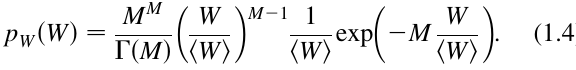
. The average of many SASE pulses is illustrated on the right, and in p b (cid:3) (cid:1)(cid:1)(cid:1)(cid:1) (cid:9) =T ! coh